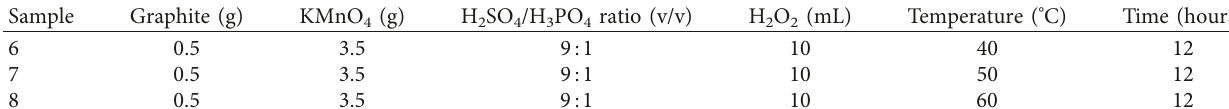
Table 2: Synthesis of GO at different reaction temperatures.